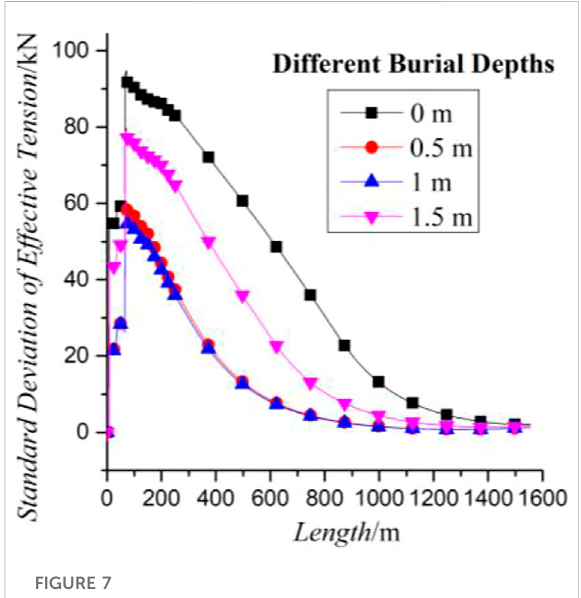
FIGURE 7 Standard deviation of the effective tension of the pipeline in the length direction with different burial